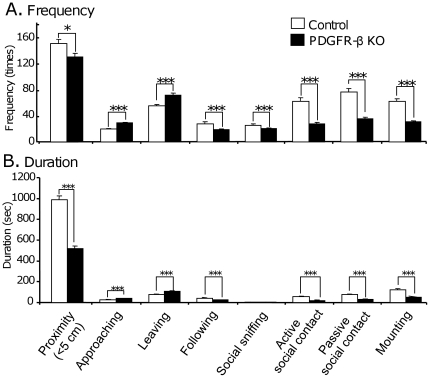
Social interactions of the PDGFR-β KO and control mice.Frequencies (A) and durations (B) of each social behavior are indicated. Black columns, PDGFR-β KO mice; white columns, control mice; *, p<0.05; **, p<0.01; and ***, p<0.001 (Student's t-test).